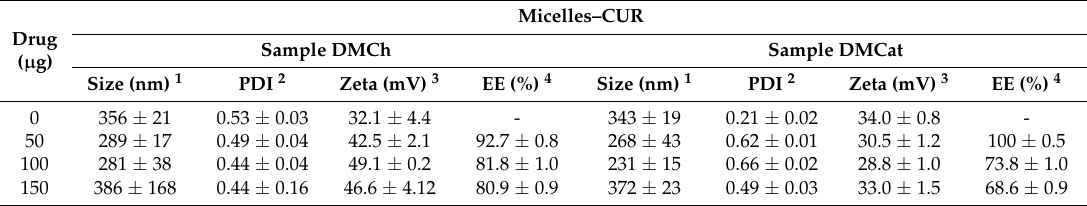
Table 1. Size, polydispersity index, zeta potential, and encapsulation efficiency of DMCh and DMCat micelles.